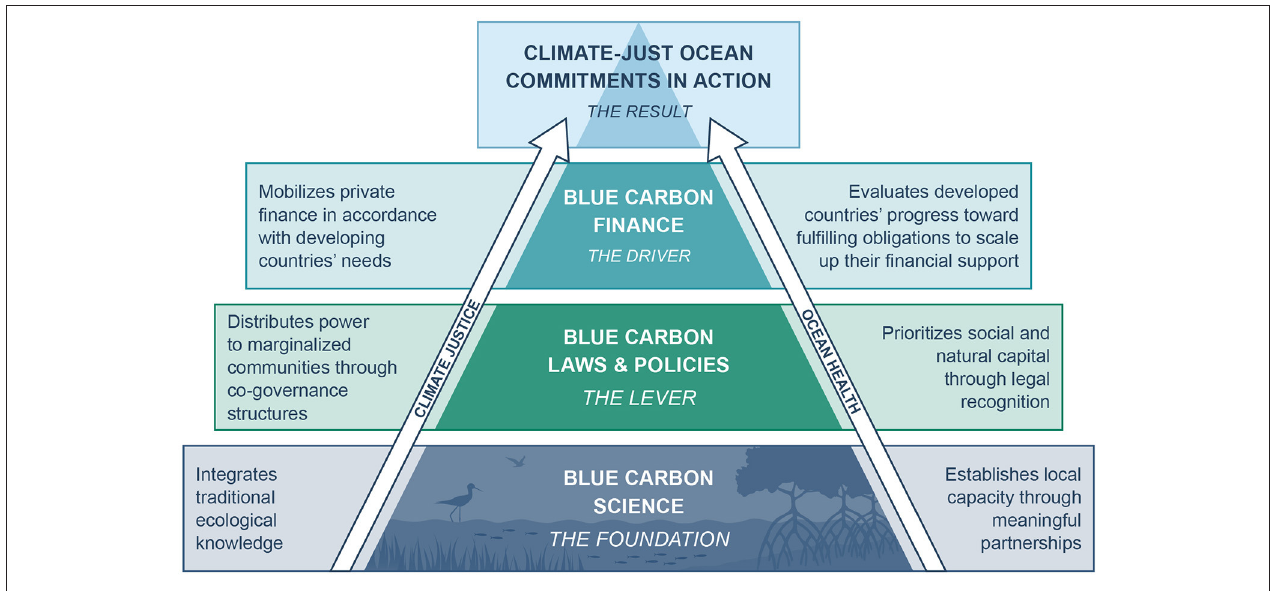
FIGURE 1 | A snapshot to guide the development of a framework for operationalizing climate-just ocean commitments under the Paris